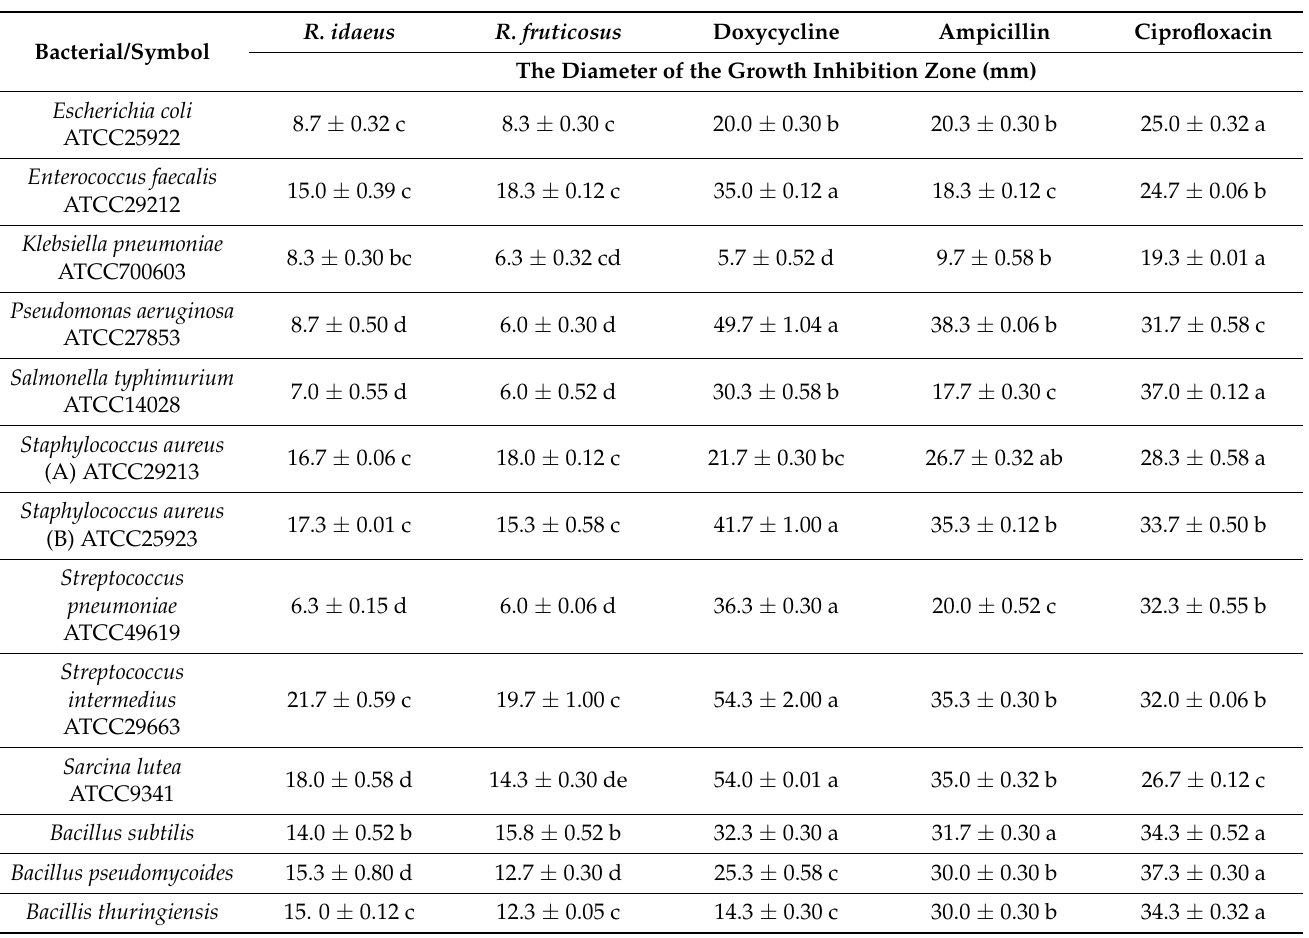
Table 6. Effects of plant preparations and antibiotics on the tested bacterial reference strains. Results were from three independent experiments (n = 3). Mean ( ± standard